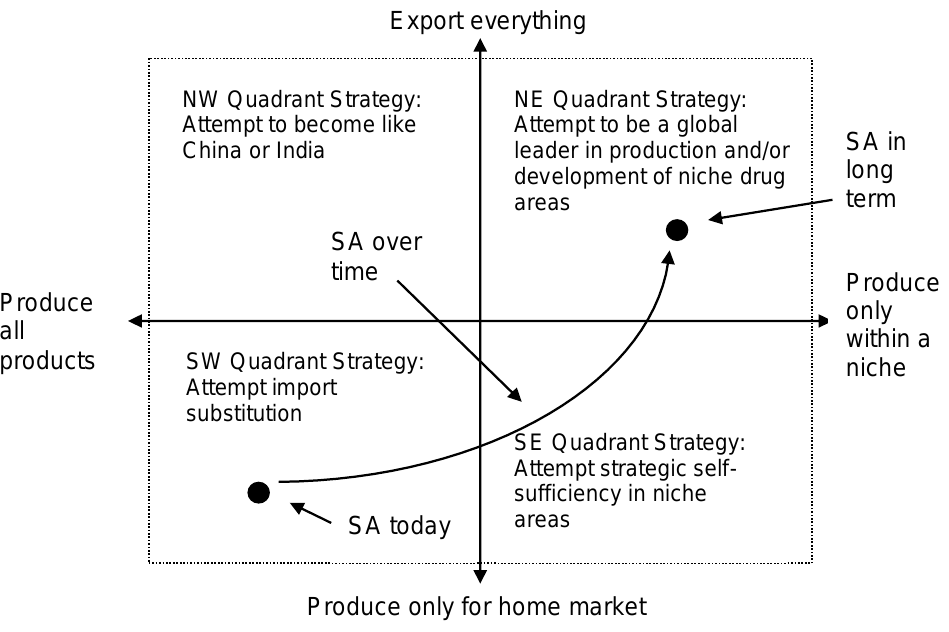
Figure 1: Proposed way forward for pharmaceuticals in South Africa Source: Maloney and Segal,